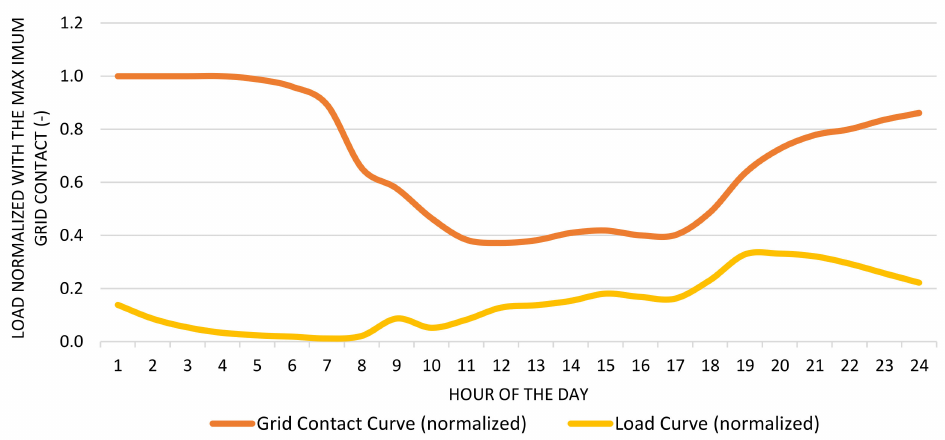
Figure 2. Depiction of the simulated realized charging profile for an exemplary day (yellow line), the maximum possible charging of all cars connected to the station (orange line), the maximum positive flexibility (blue arrow) and maximum negative flexibility (black arrow), normalized